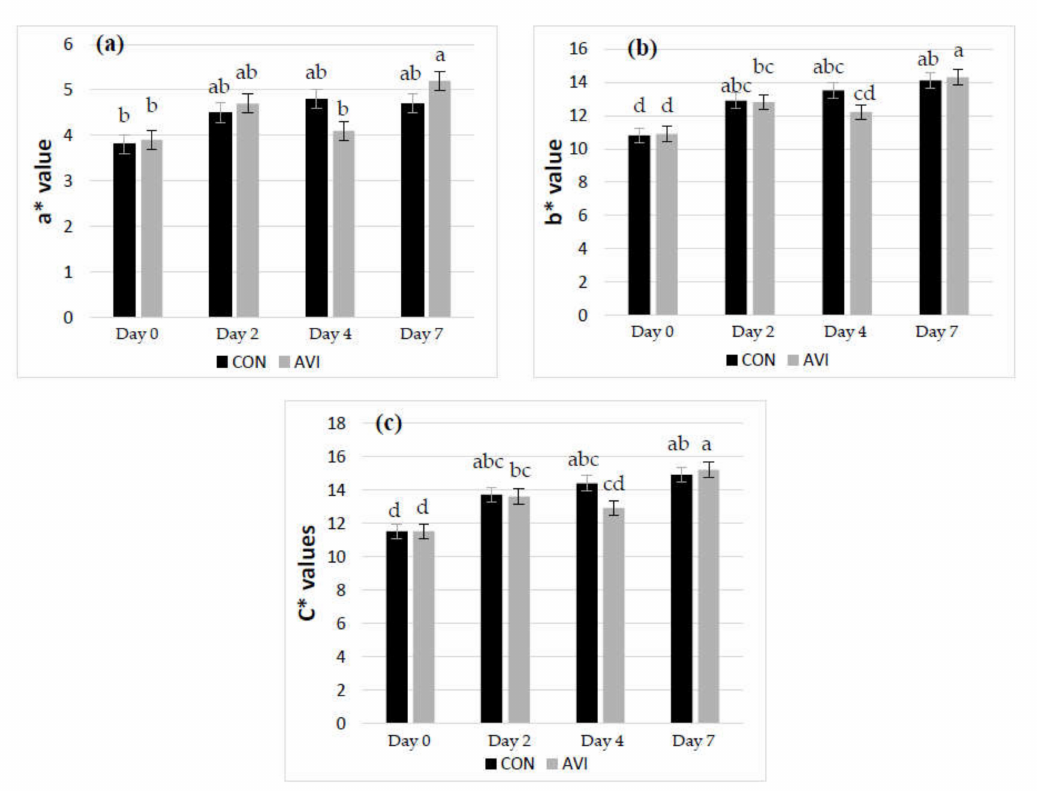
Figure 3. Interactive e ff ect of dietary treatment (CON, basal diet; AVI, basal diet + 0.5% organic acids and essential oils) and time of storage (days 0, 2, 4 and 7) on a*, b* and C* values in cooked meat, ( a ), ( b ) and ( c ) respectively. a–d Values with di ff erent superscripts are significantly di ff erent ( p <